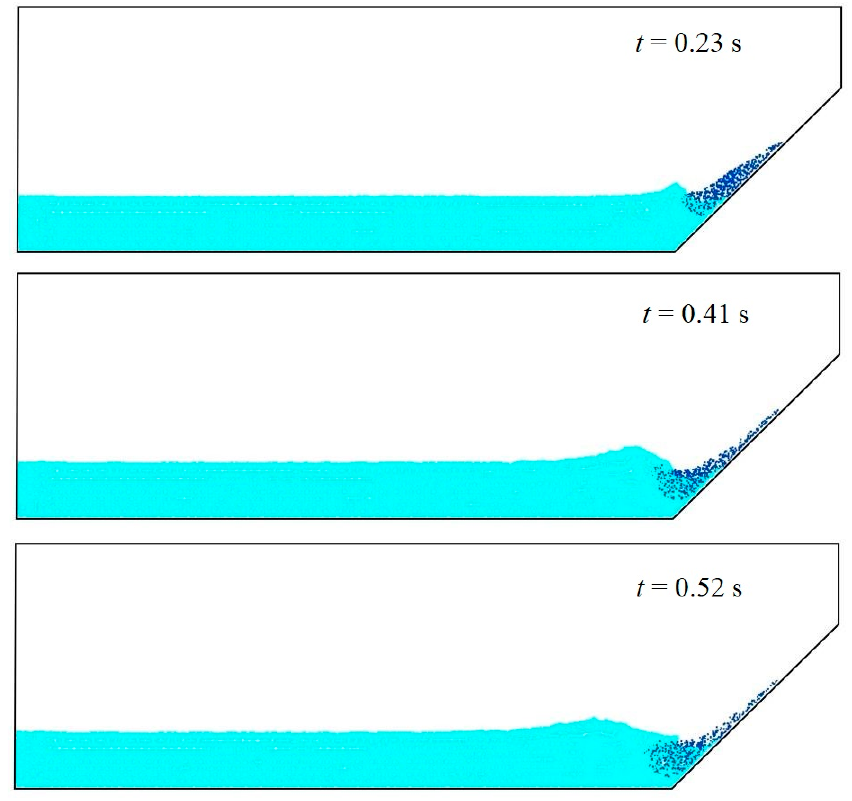
Figure 7. Morphology of water waves generated by dry granular bodies entering the water at different